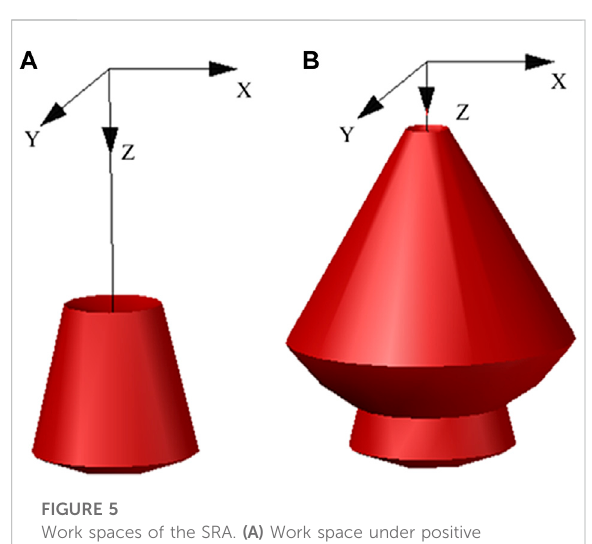
FIGURE 5 Work spaces of the SRA. (A) Work space under positive pressure. (B) Work space under positive and negative